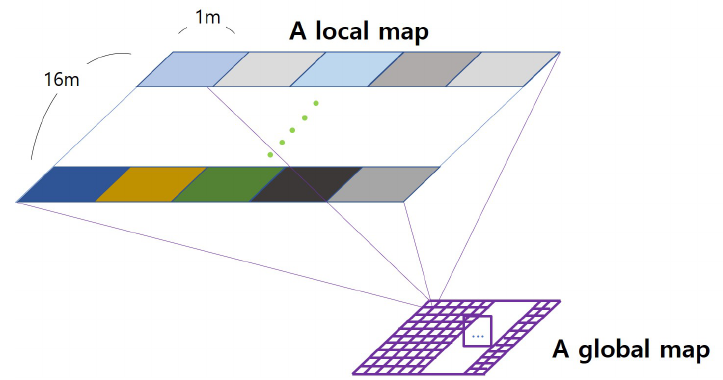
Figure 3. Basic two-layer hierarchical